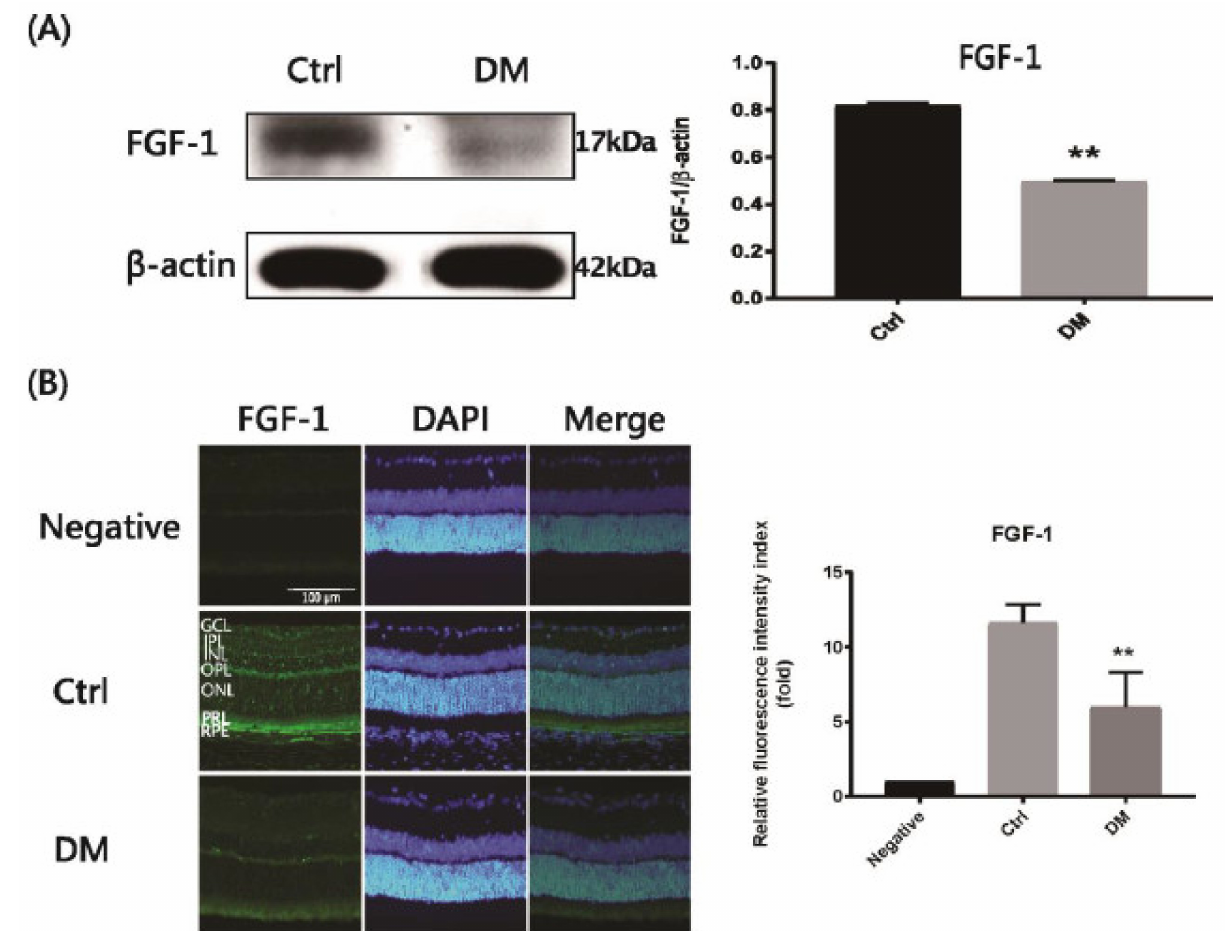
Figure 1. Endogenous levels of FGF-1 in diabetic Sprague-Dawley (SD) rats. ( A ) Western blot of FGF-1 in the retinal tissues of 12-week-old SD rats. The bar graph illustrates the relative intensity of western blot bands, normalized to β -actin expression ( n = 4 eyes in each group). ( B ) Immunofluorescence image of FGF-1 expression in the retinal tissue of 12-week-old SD rats. Bar = 100 µ m. The relative densities of immunofluorescence images were normalized to the negative control ( n = 4 eyes in each group). All data are presented as mean ± standard deviation. ** p < 0.01 compared with the control group; Ctrl, control group; DAPI, 4 (cid:48) ,6-diamidino-2-phenylindole; FGF-1, fibroblast growth factor type 1; DM, STZ- induced diabetic rat group; Negative, negative control